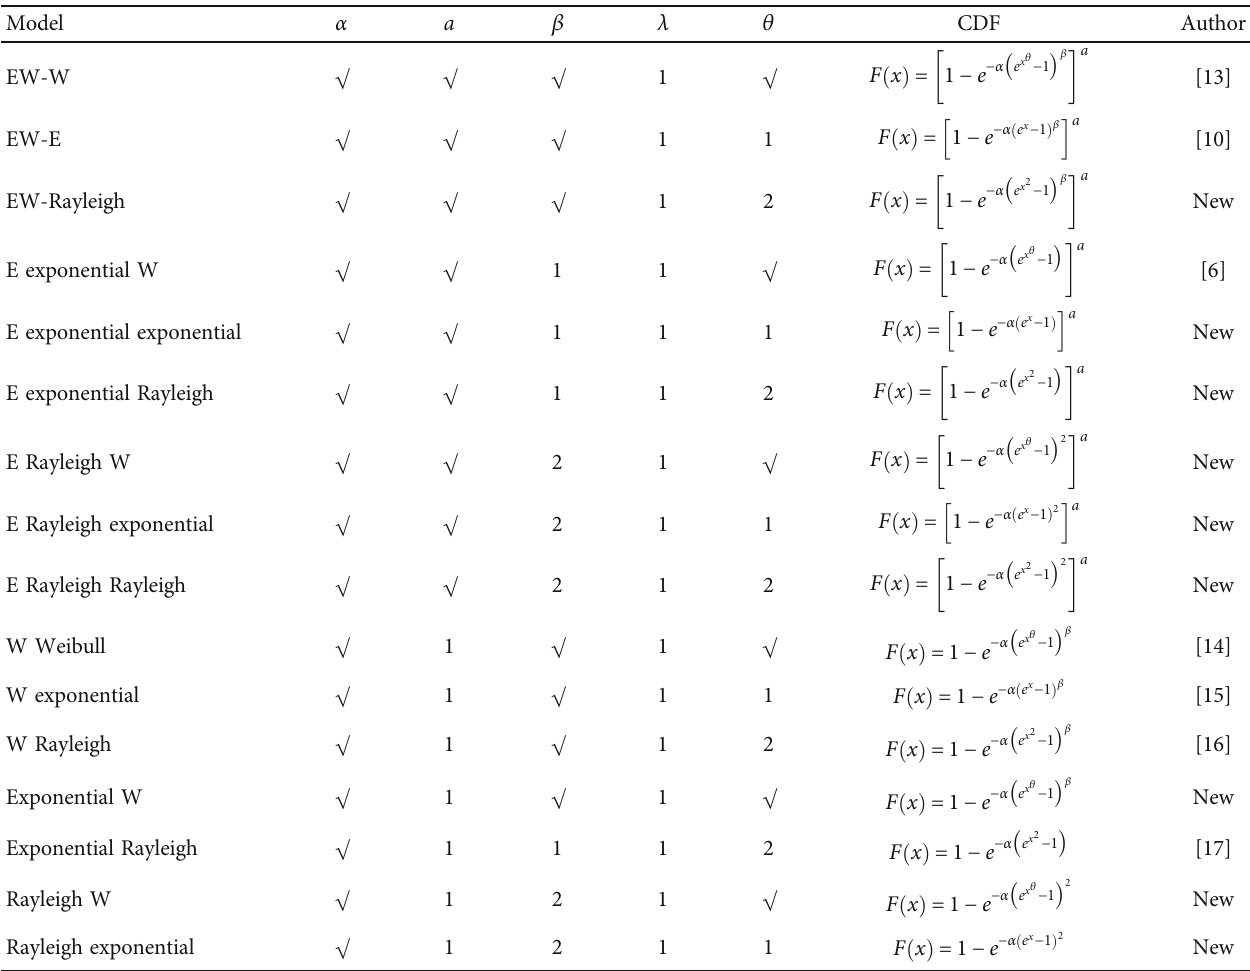
Table 1: Subdistributions of the EW-EW